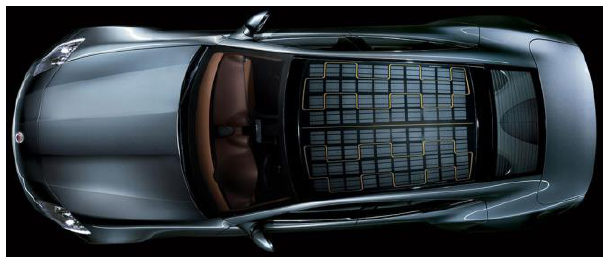
Fig. 6. Solar roof of the KARMA Revero